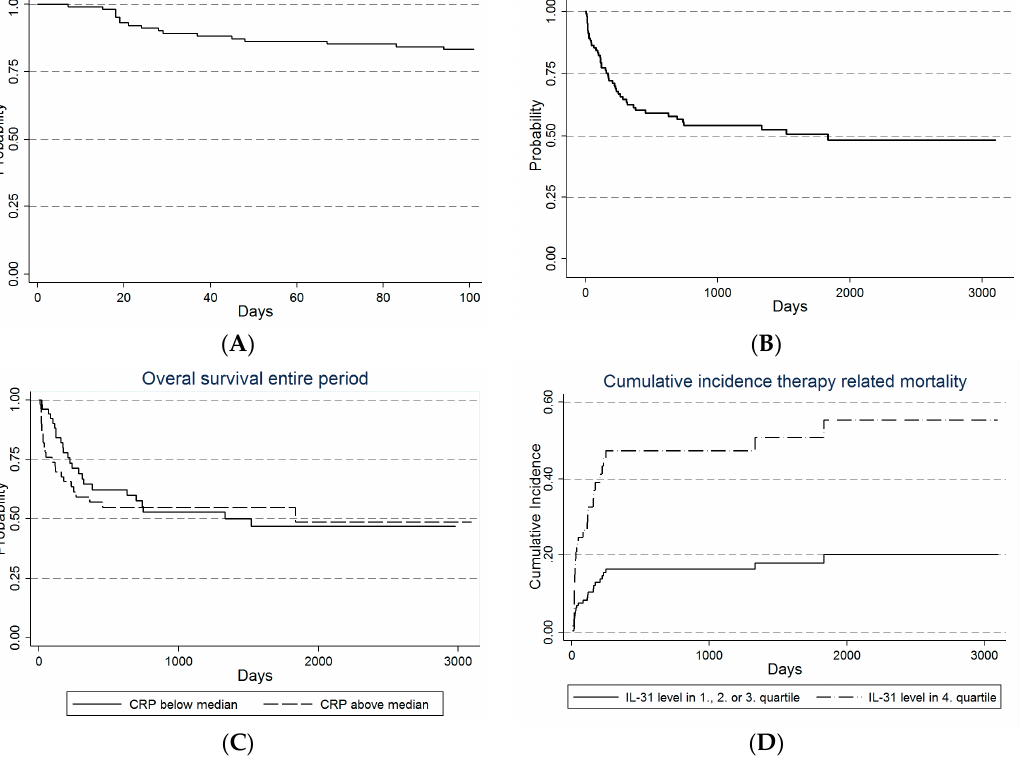
Figure 2. Survival after allogeneic stem cell transplantation for all patients included in our study. The Kaplan–Meier plots show: ( A ) overall survival for the first 100 days posttransplant and ( B ) overall survival for the entire period; ( C ) the effect on the overall survival of pretransplant CRP levels above or below the median CRP serum level; and ( D ) the cumulative incidence of TRM for patients with either low (quartiles 1–3) or high pretransplant IL-31